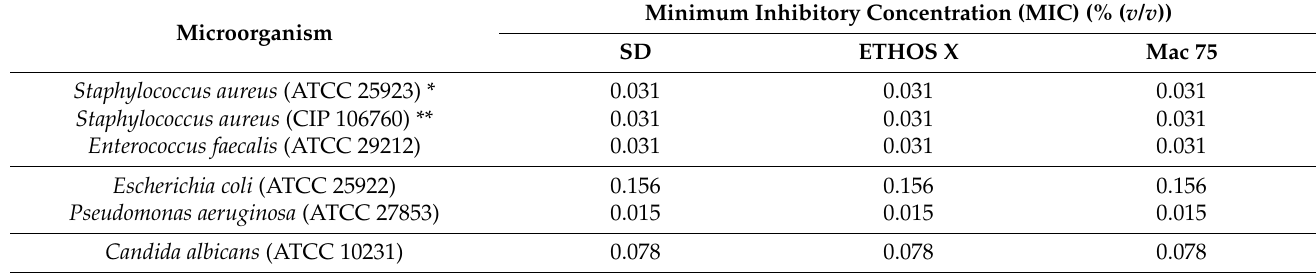
Table 2. Evaluation of the antimicrobial activity of Thymus mastichina essential oils obtained using steam distillation (SD) and solvent-free microwave extraction (SFME) at laboratory (ETHOS X) and pilot scale (Mac 75). Minimum Inhibitory Concentration (MIC) (% ( v / v )) Microorganism SD ETHOS X Mac 75 Staphylococcus aureus (ATCC 25923) * 0.031 0.031 0.031 0.031 0.031 0.031